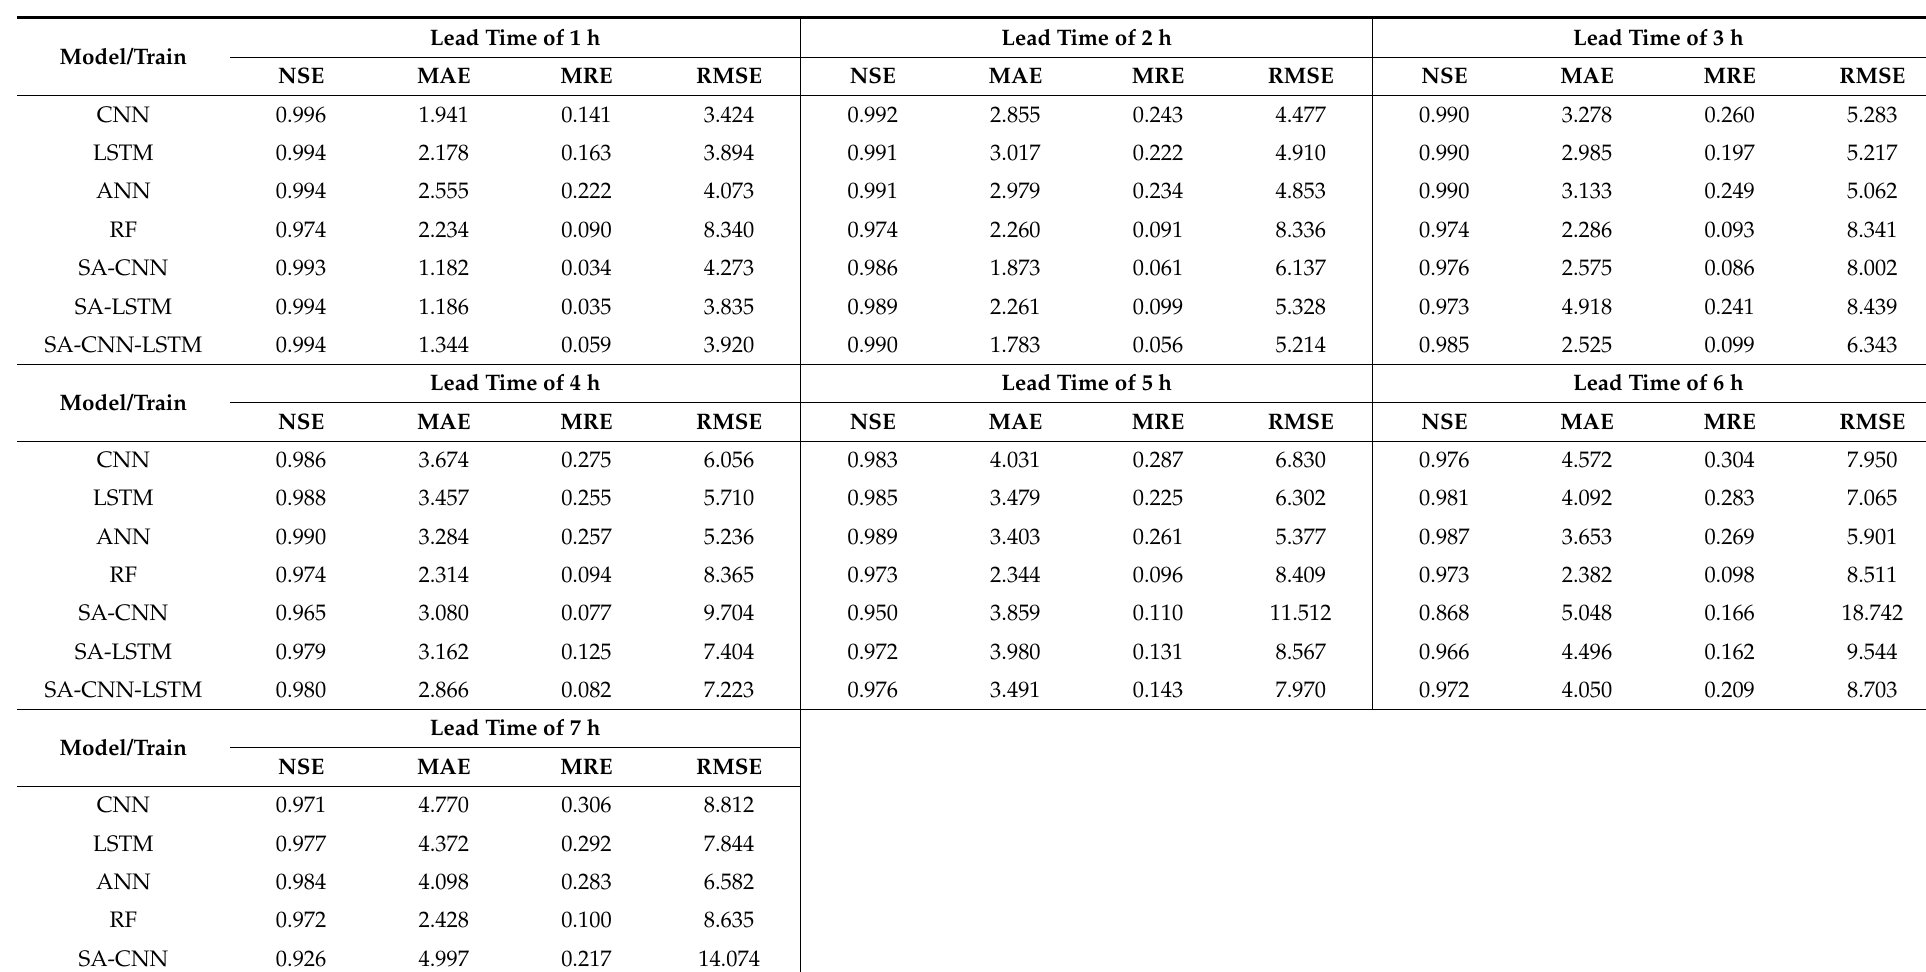
Table 2. Performances of each model in the training